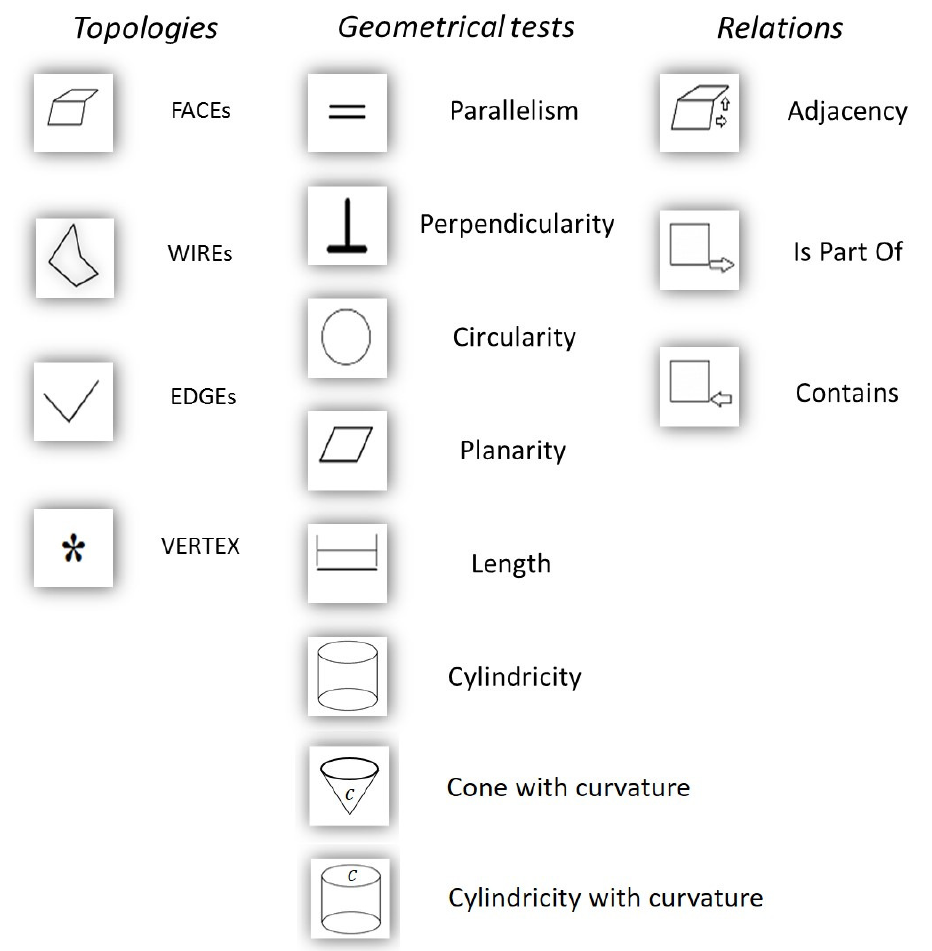
Figure 12. Topologies, topological relations and geometrical tests implemented.